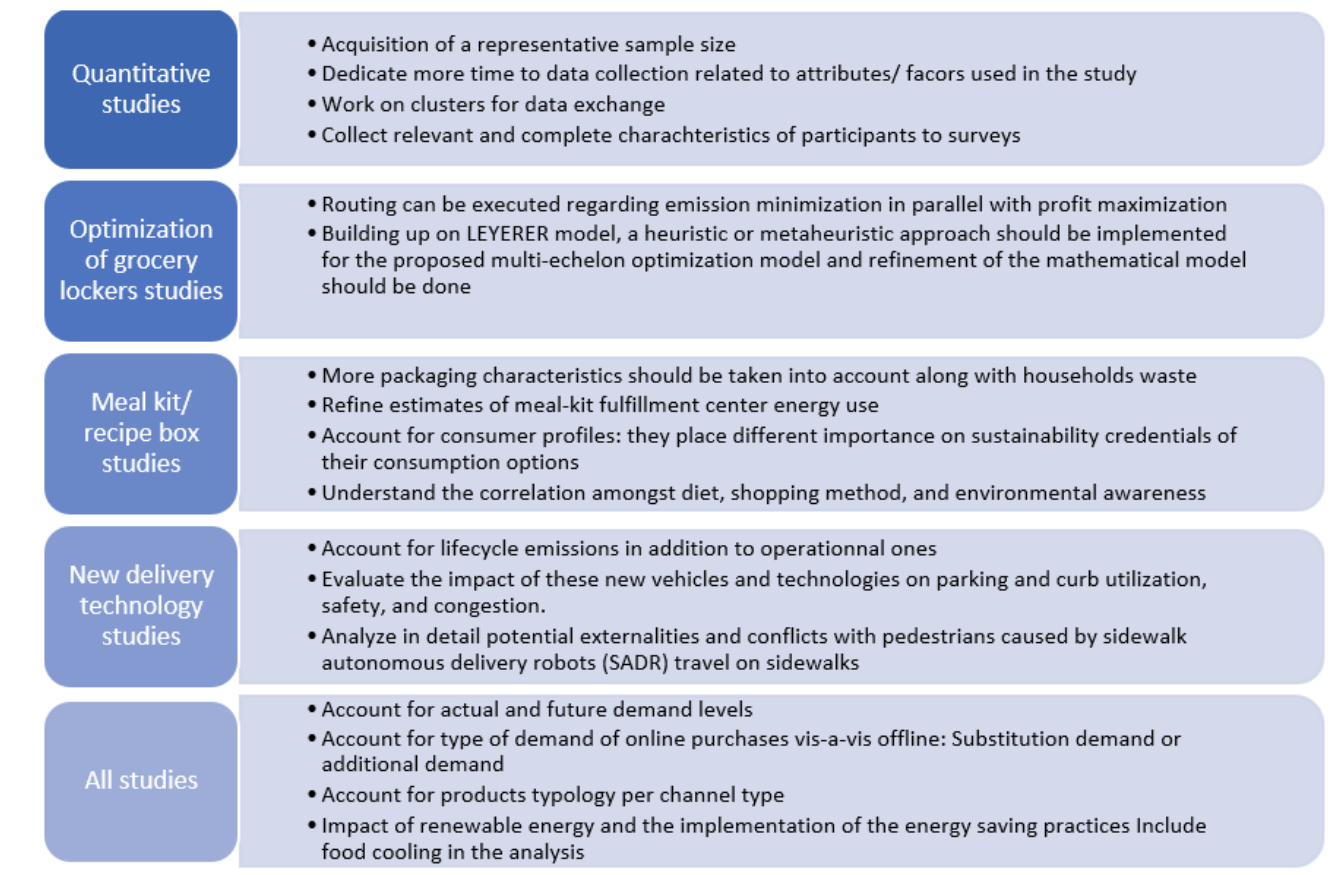
Figure 6. Future research agenda per study type .